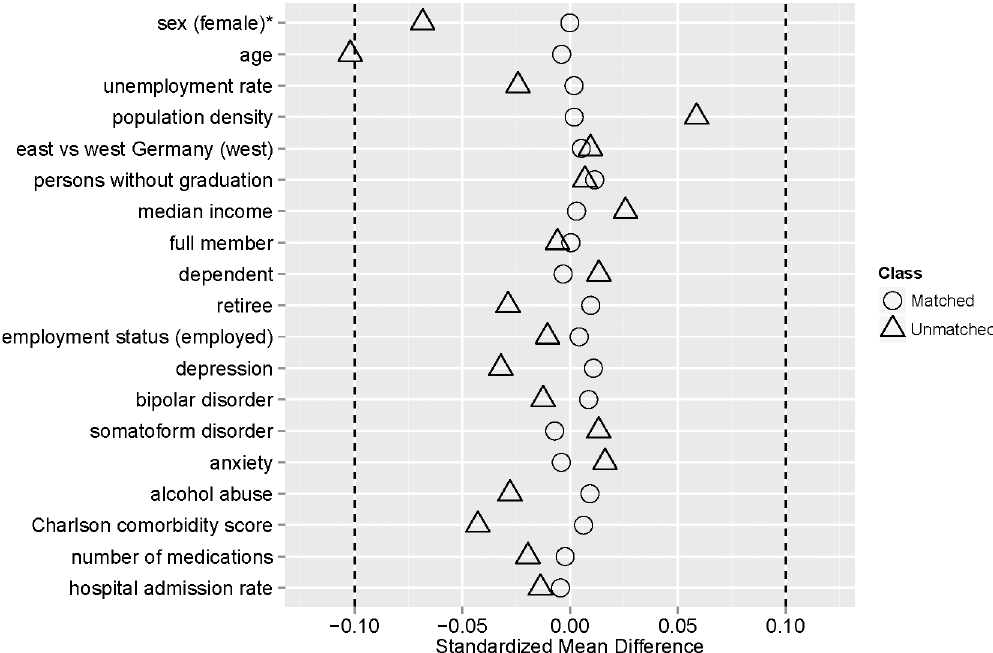
Fig 2. Absolute standardized differences before and after propensity score matching comparing covariate values for patients receiving spinal manipulation therapy and controls.